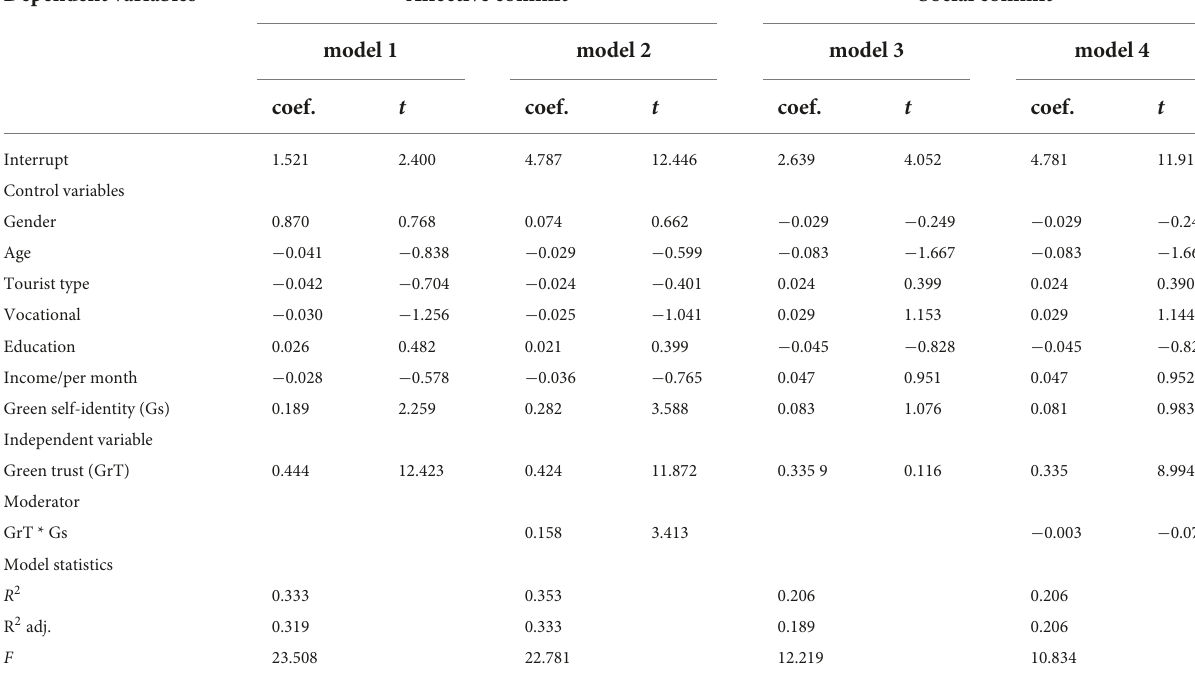
TABLE 6 Moderation effect of green